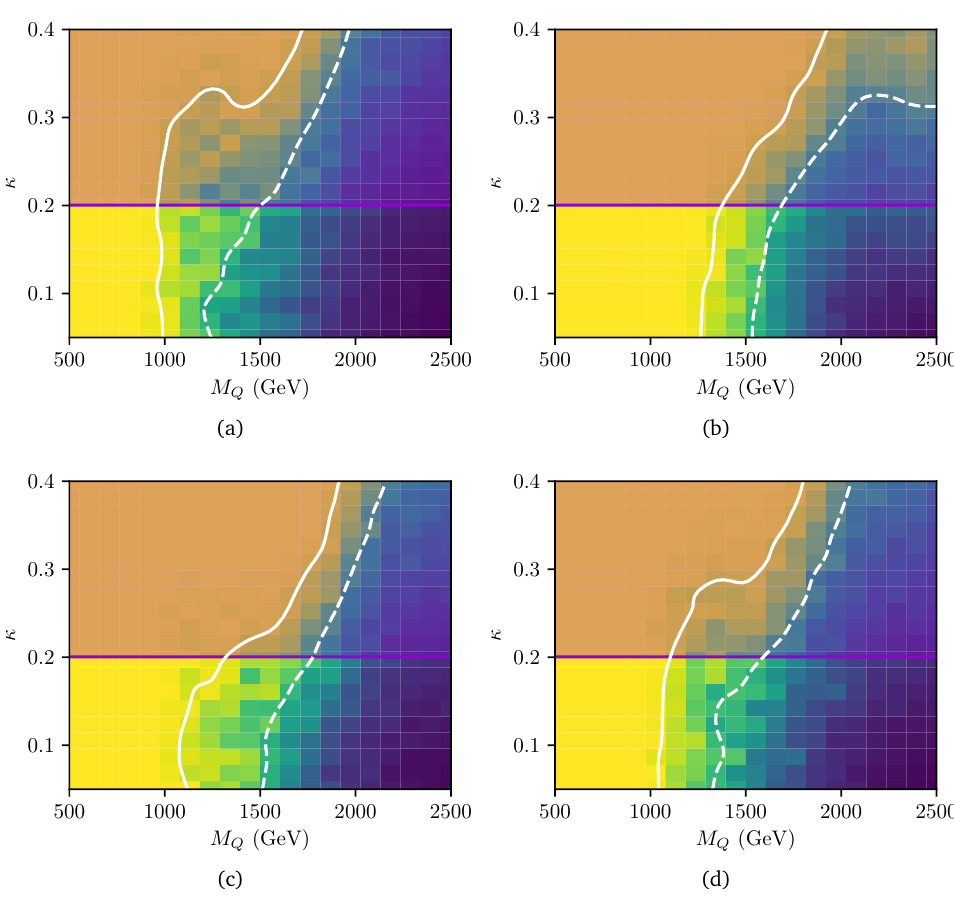
Figure 21: Sensitivity of LHC measurements to VLQ production in the κ vs VLQ mass plane, where κ is the coupling to second-generation SM quarks. All VLQ ( B , T , X , Y ) masses are set to be degenerate. The green and yellow regions are disfavoured at 68% CL and 95% CL respectively, with the dashed and solid white contours delineating the boundaries. The VLQ branching fractions to W : Z : H are (a) 0:0:1 (b)